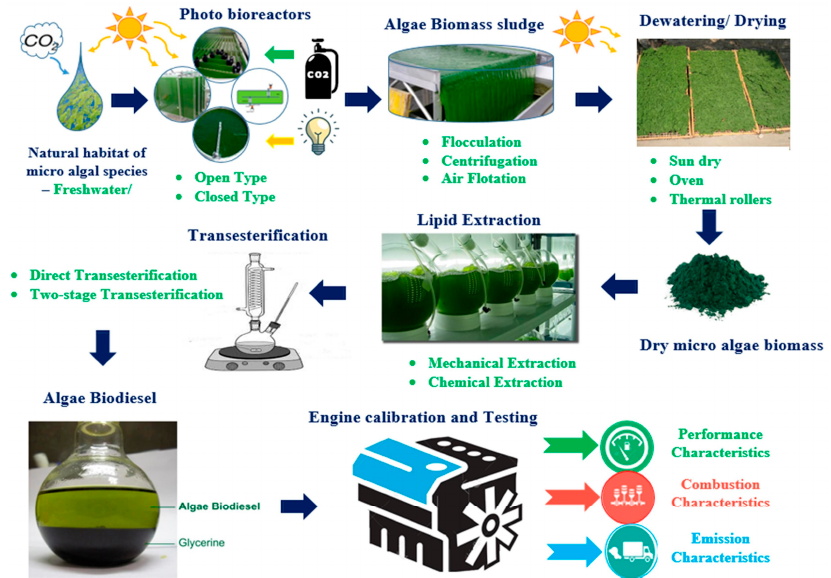
Figure 10. Micro ‐ algal biodiesel production technique and components in processing [143]. Figure 10. Micro-algal biodiesel production technique and components in processing Table 6. Properties of third ‐ generation biodiesel [144–150].